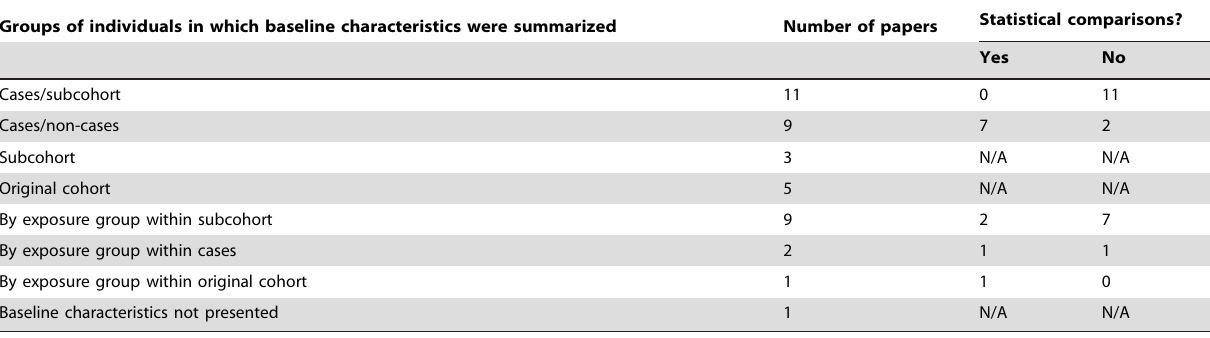
Groups of individuals in which baseline characteristics were summarized